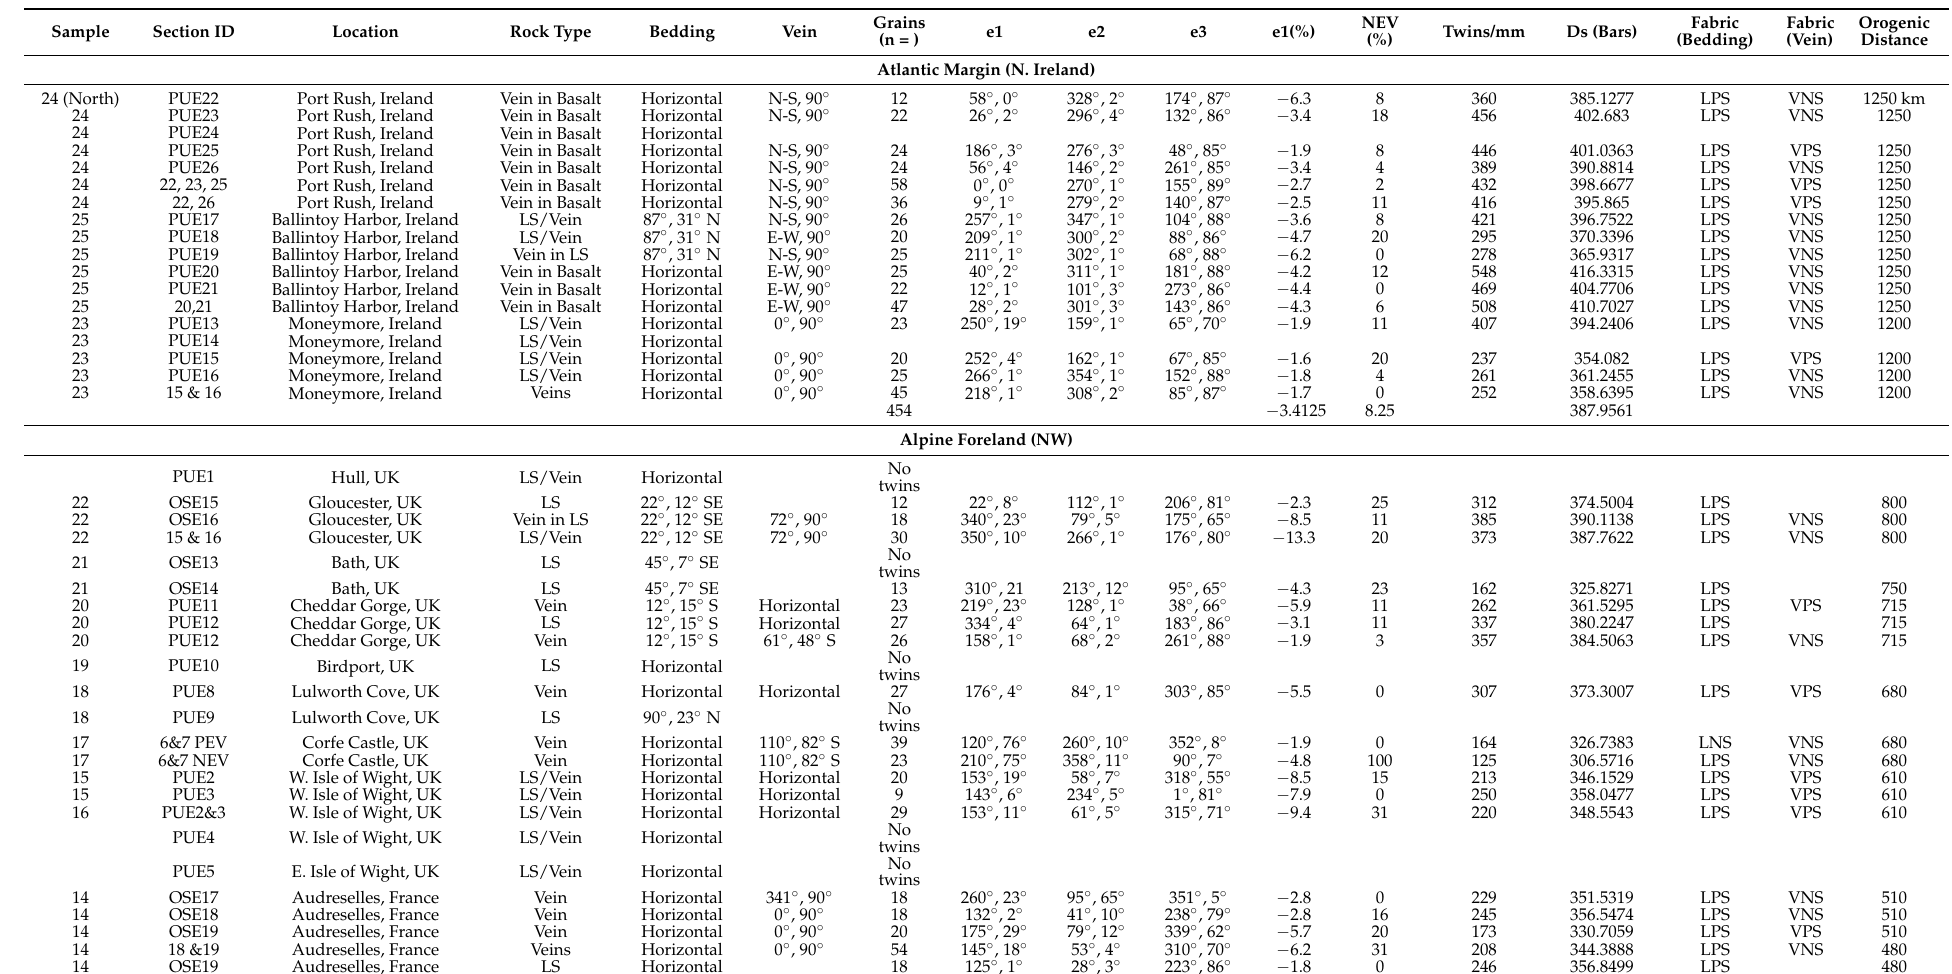
Table 2. Calcite strain